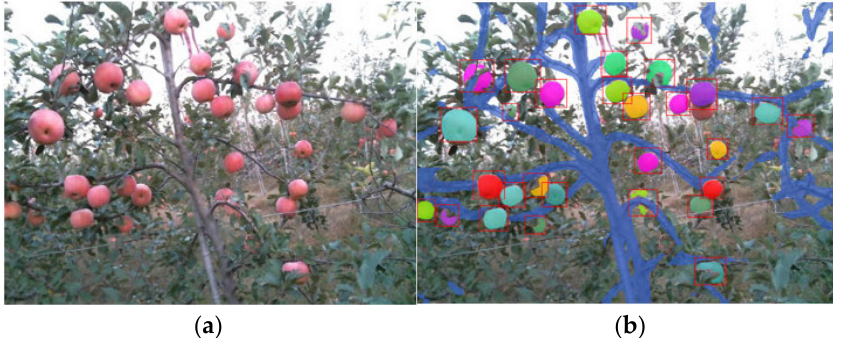
Figure 8. Instance segmentation for apple fruit (Photo: Reprinted with permission from Ref. [34]. 2019, Kang H.). ( a ) The original image; ( b ) the instance segmentation result.